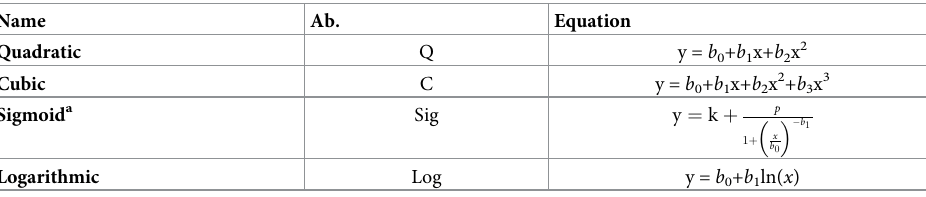
Table 1. Empirical models used in the current